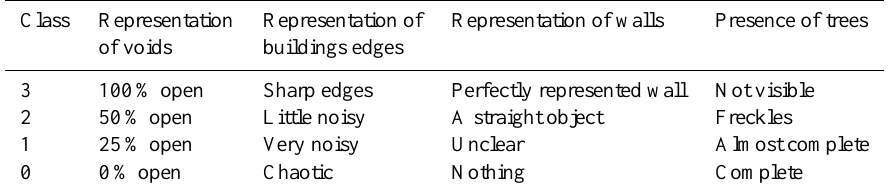
Table 1. Qualitative metric classes. Class Representation Representation of Representation of walls Presence of trees of voids buildings edges 3 100% open Sharp edges Perfectly represented wall Not visible 2 50% open Little noisy A straight object Freckles 1 25% open Very noisy Unclear Almost complete 0 0% open Chaotic Nothing